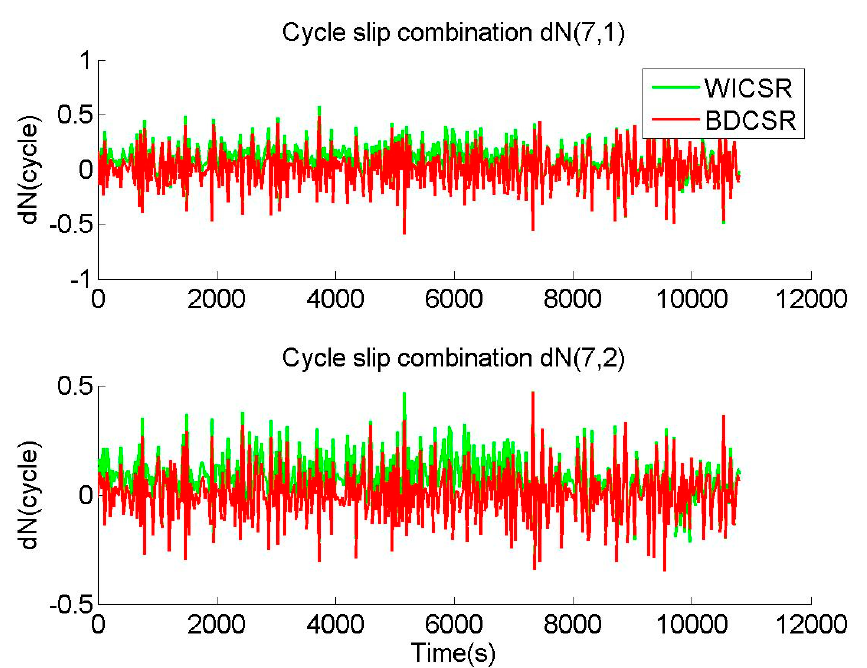
Figure 3. The cycle-slip combinations of WICSR without correcting the ionospheric variations and those of the BDCSR methodology after correcting the ionospheric variations, where the BDS dual-frequency pseudoranges and phases without cycle slip were collected from the GEO Satellite 2 during the geomagnetic storm, started from UTC 8 May 2016 00:00:00 with an interval of 30 s at the CUT0 station.